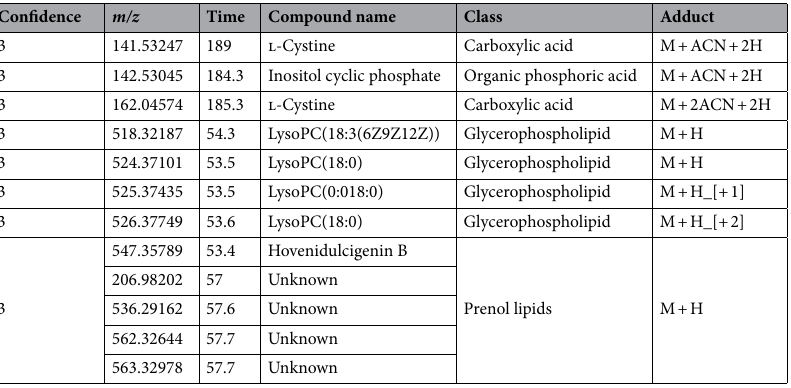
Table 3. Top 12 significant metabolites overlapping between days from transplant analysis and